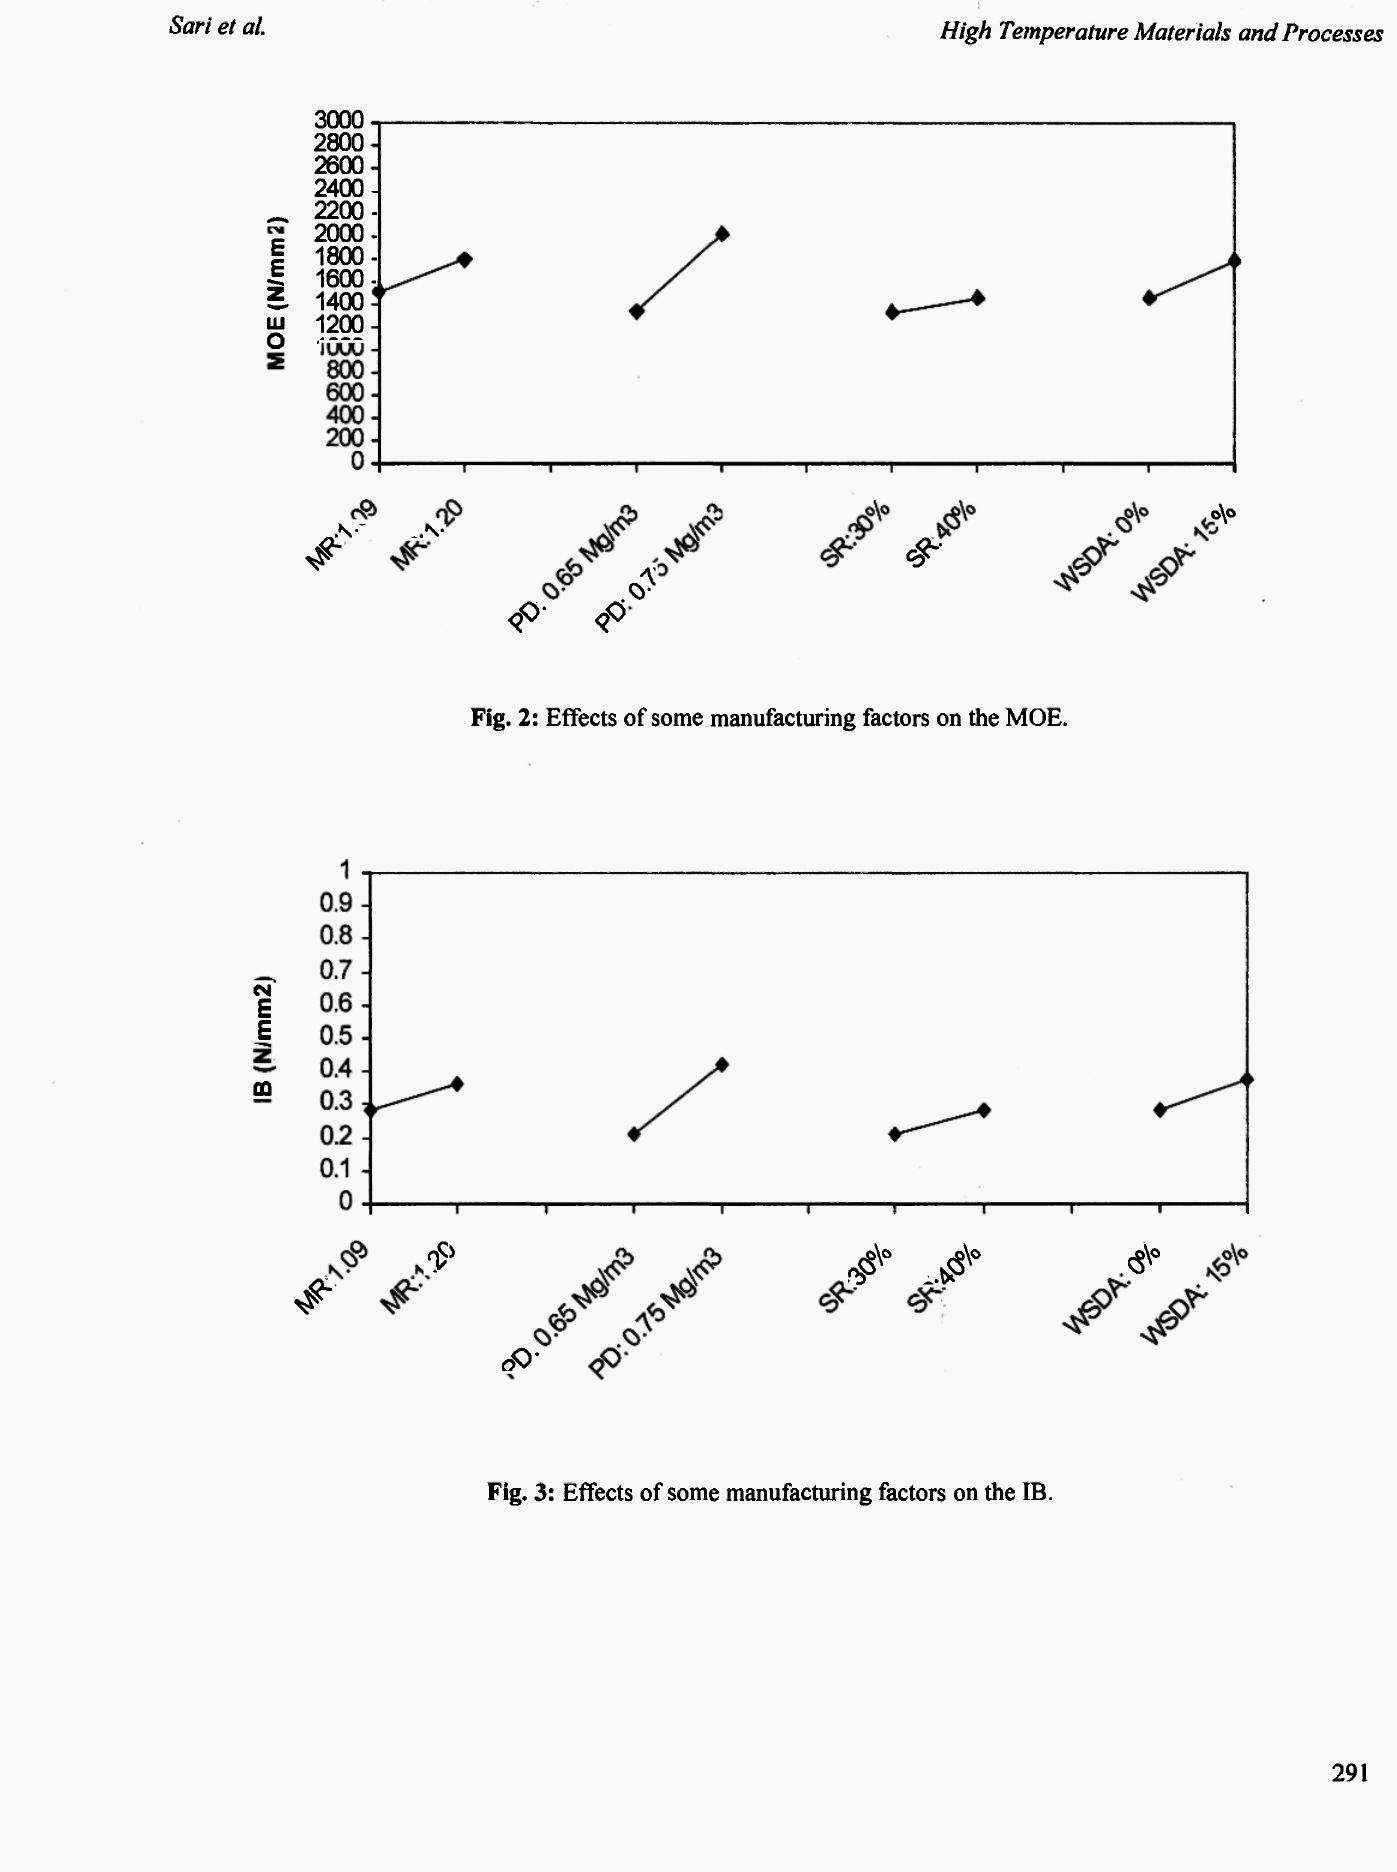
Fig. 3: Effects of some manufacturing factors on the